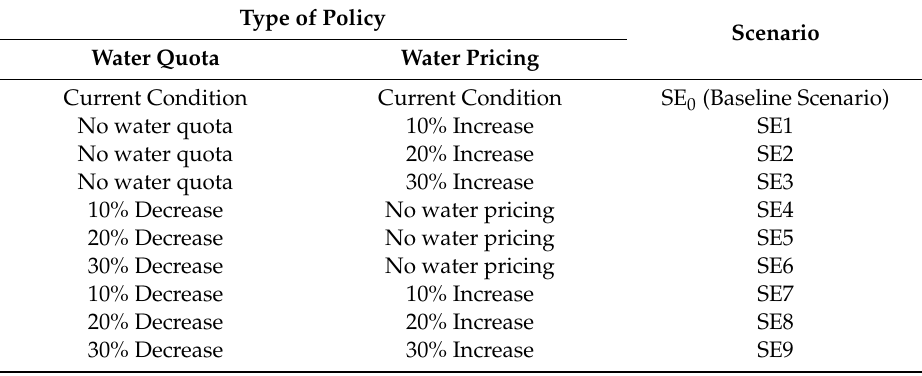
Table 3. Di ff erent policy scenarios of water pricing and water quota in Ghorveh